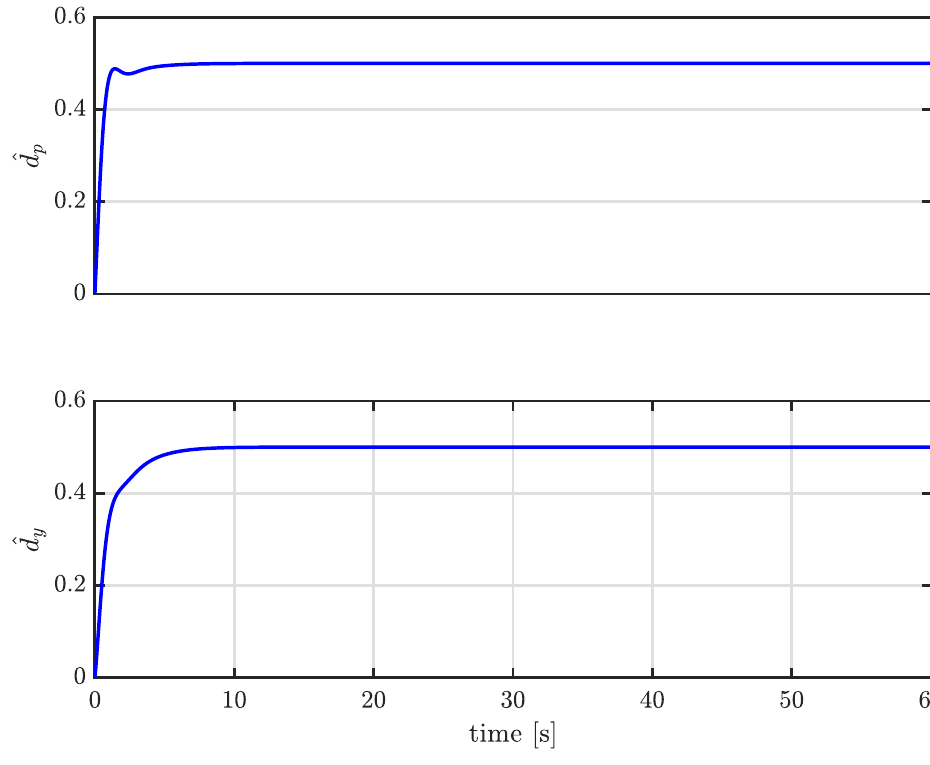
Figure 5. Estimated disturbances (Case I-simulation).